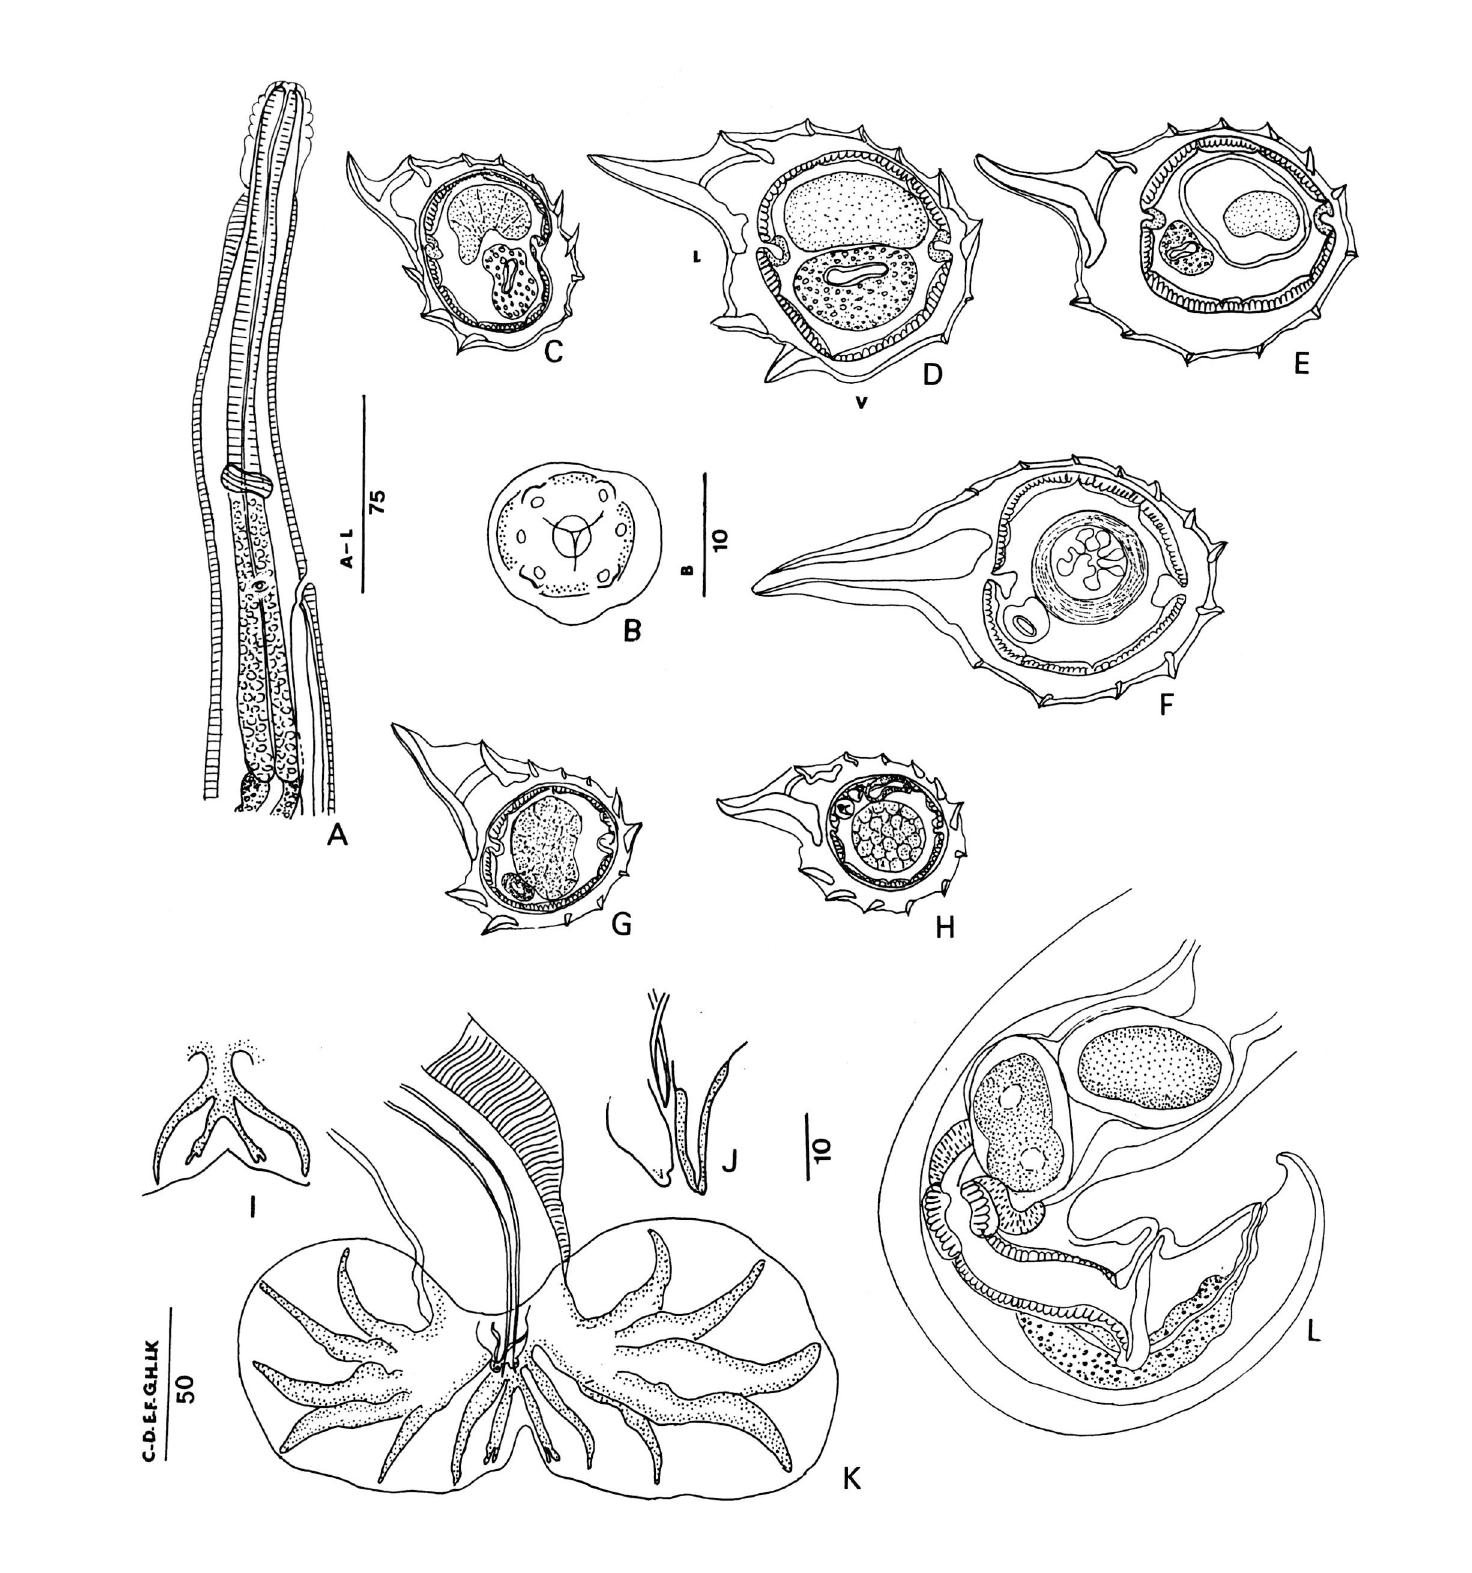
Fig.l- Heligmonitia wrightae n. sp. A, female, anterior extremity, right lateral view; B, female, head, apical view; C-H, cuticular ridges, transverse sections, C-F, female, C, at the beginning of the intestine, D, at mid-body, E, at 900 from caudal extremity, F, at 100 from vulvar opening; G, H, male, G, at mid-body, H, in front of caudal bursa; I, male, arising of rays 8, dorsal view; J, male, genital cone, right lateral view; K, other male, caudal bursa, ventral view; L, female, posterior extremity, right lateral view. Transverse sections orientated as figure 1, D. Abbreviations : V, ventral side; L, left side. Parasite, 2002, 9,